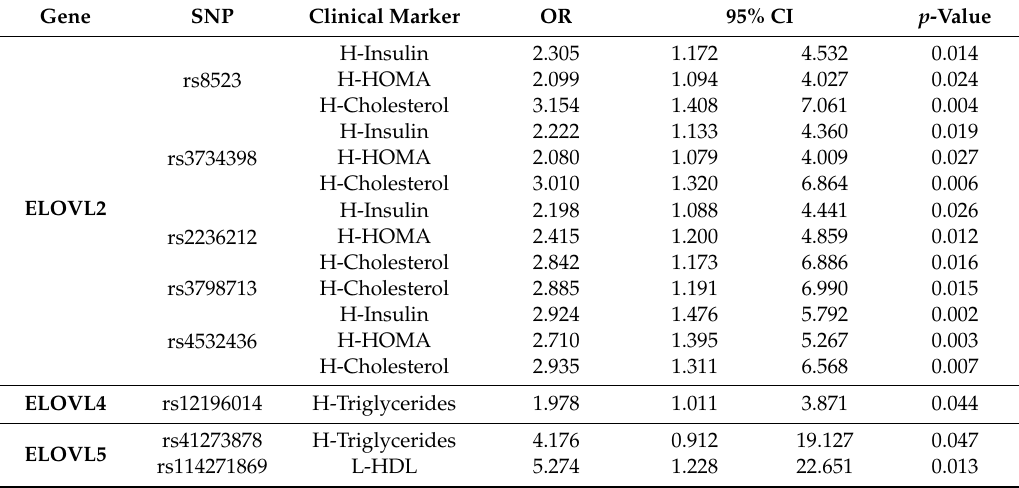
Table 8. Association of SNPs with clinical markers of chronic non-communicable diseases in men (risk factors). Gene SNP Clinical Marker